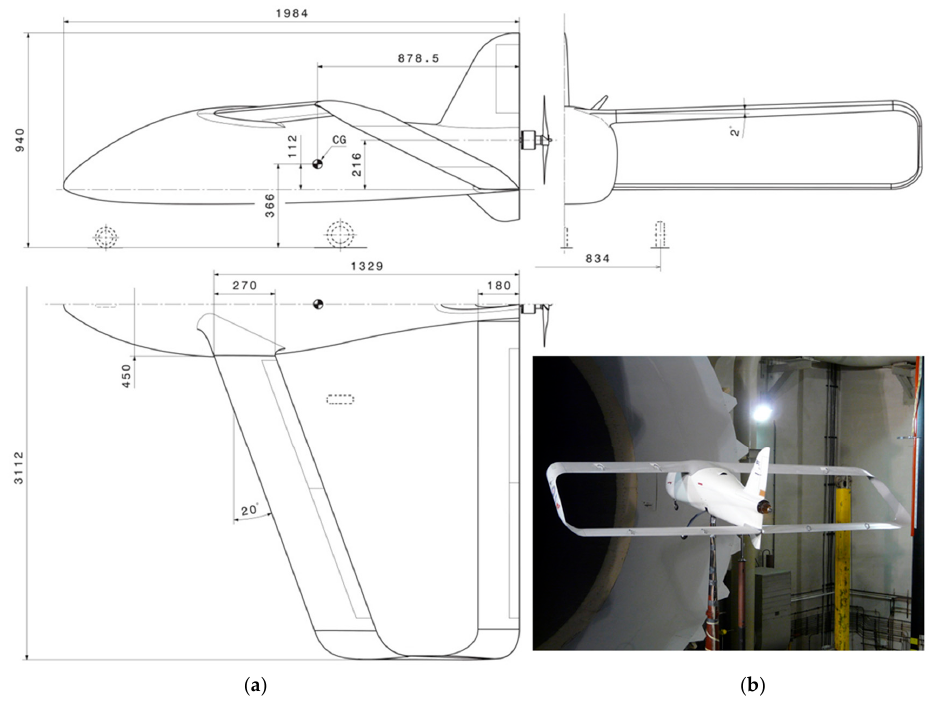
Figure 2. ( a ) Three views of the inverted joined wing demonstrator; and ( b ) demonstrator in the wind tunnel.